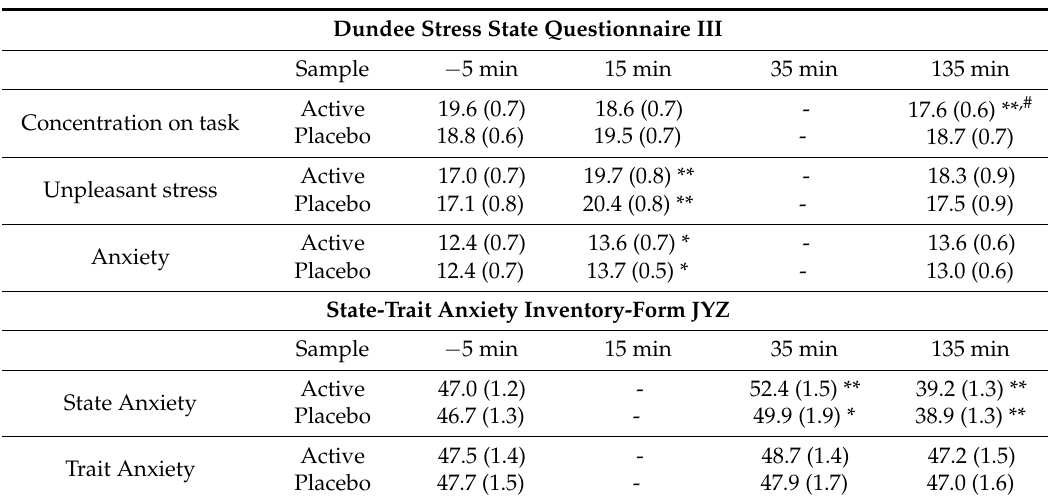
Table 3. Results of the questionnaires ( n =